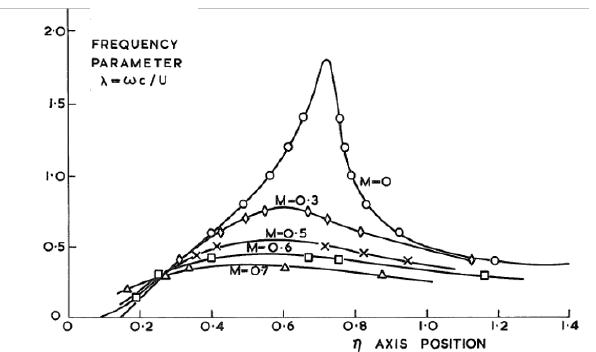
Figure 18. Stability map for an infinite cascade of flat plates with ξ = 45°, s / c = 1.0, η = x / c . (Whitehead,